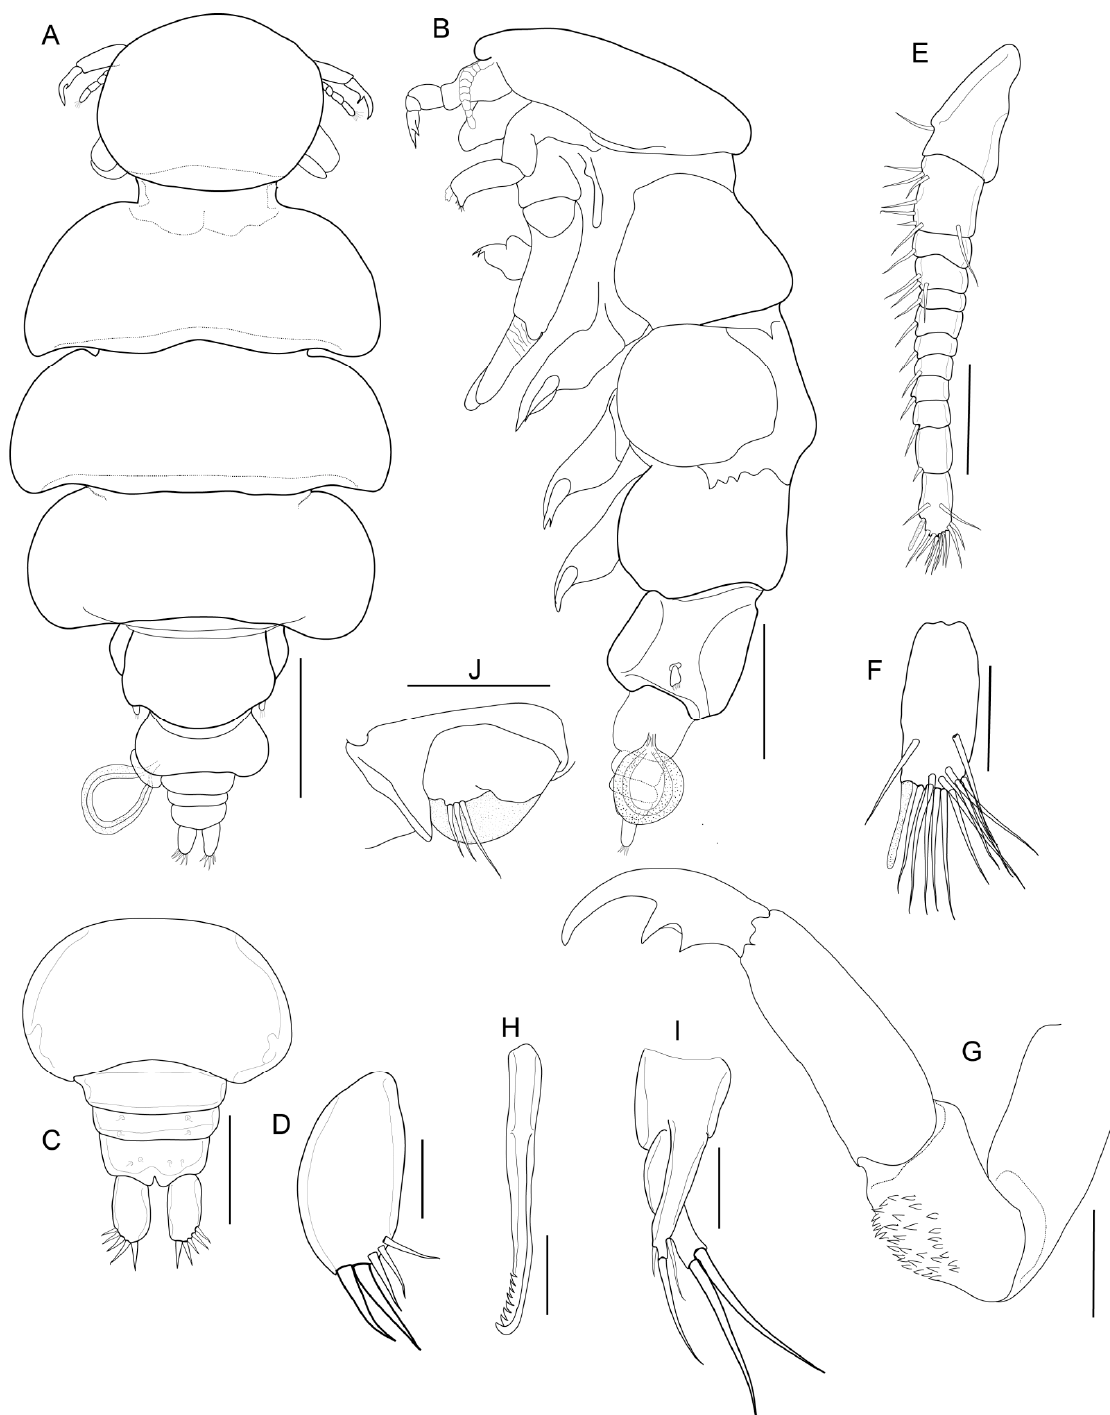
Figure 2. Nemesis santhadevii sp. nov. from Atelomycterus marmoratus , paratype female. ( A ) habitus, dorsal view; ( B ) habitus, ventral view; ( C ) genito-abdomen; ( D ) caudal ramus; ( E ) antennule; ( F ) antennule apex; ( G ) antenna; ( H ) mandible; ( I ) maxillule; and ( J ) leg 5. Scale bar: ( A , B ) = 1 mm; ( C ) = 0.5 mm; and ( D – J ) = 0.01 mm.